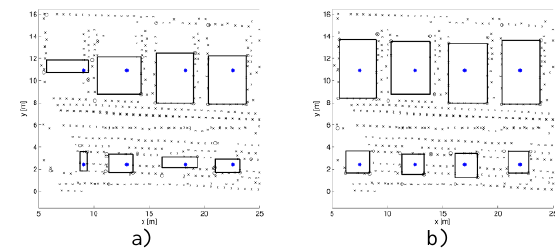
Figure 14. Window outline hypothesis for a façade part. a) Automatically determined seed points, b)